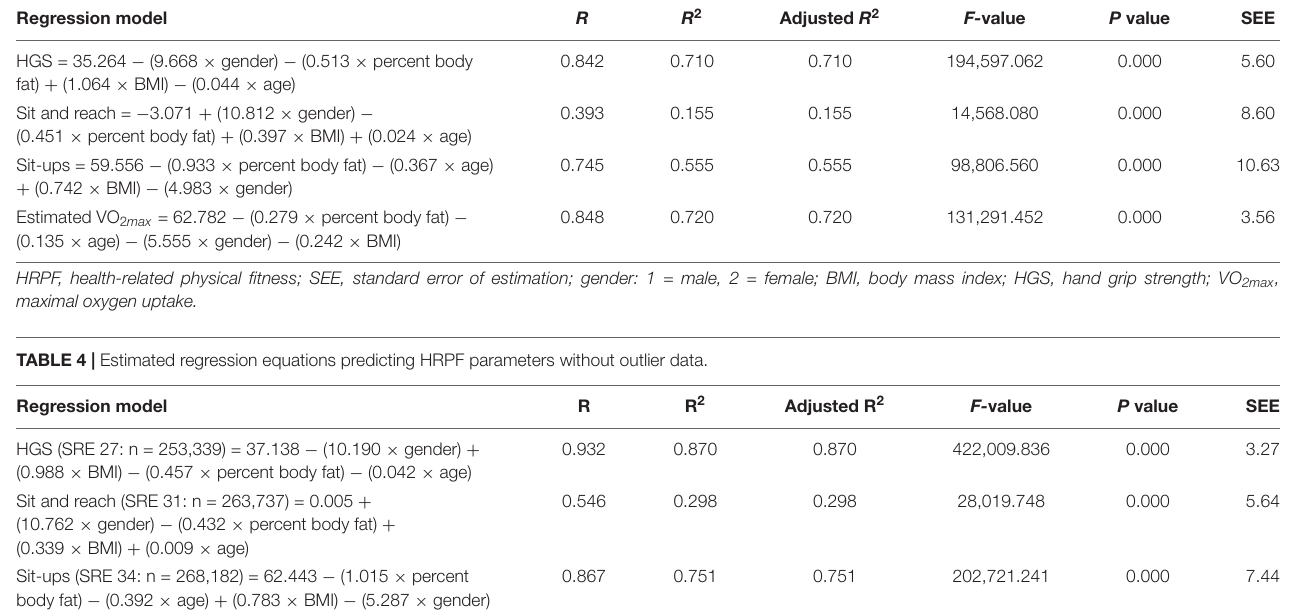
TABLE 3 | Estimated regression equations predicting HRPF parameters. Regression model